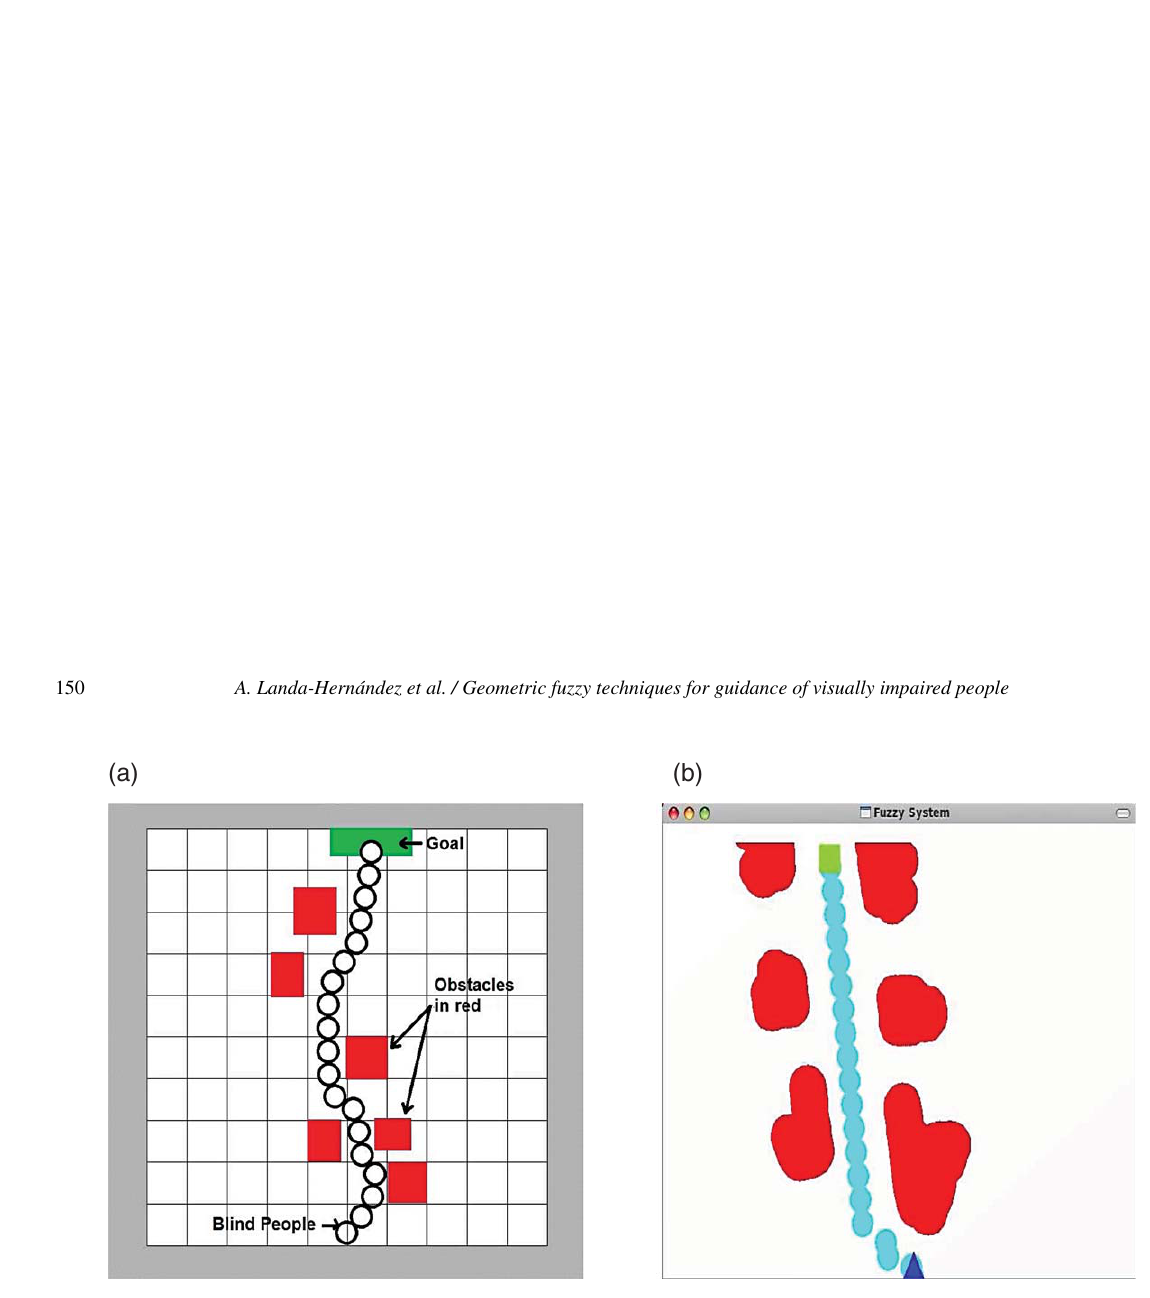
Fig. 16. (a) (left) Example of a navigation path avoiding obstacles; (b) (right) one path generated by the inference engine processing in real time using the stereo data, vanishing points, and the obstacle’s location on the floor map. of cell: 8; overlap of blocks: 1; normalized factor for